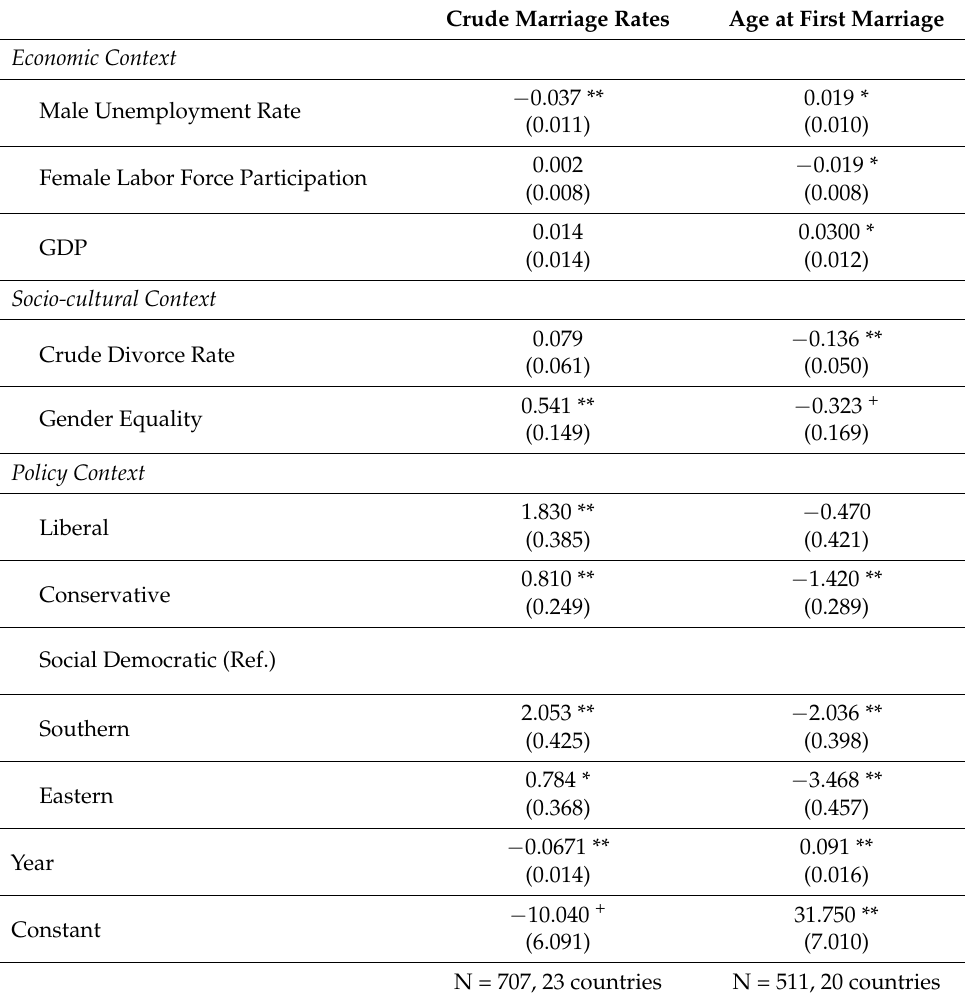
Table 3. Panel Corrected Prais-Winsten Models for Marriage Rates and Age at First